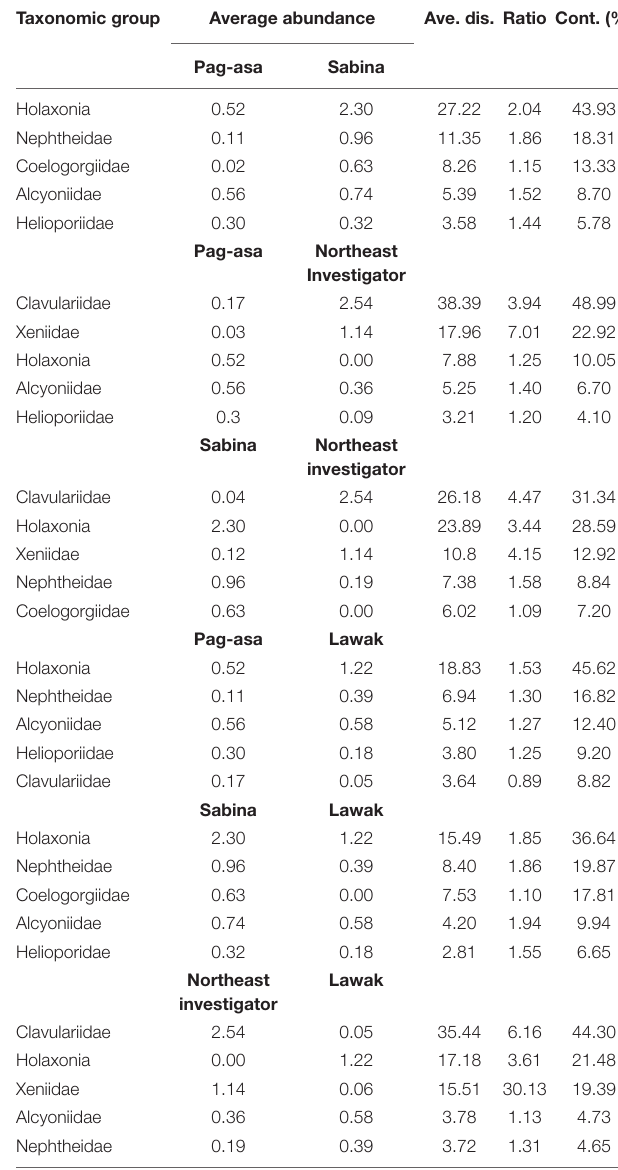
TABLE 3 | Dissimilarity percentages among sites from the SIMPER analysis among sites in the Kalayaan Island Group in 2017. Taxonomic